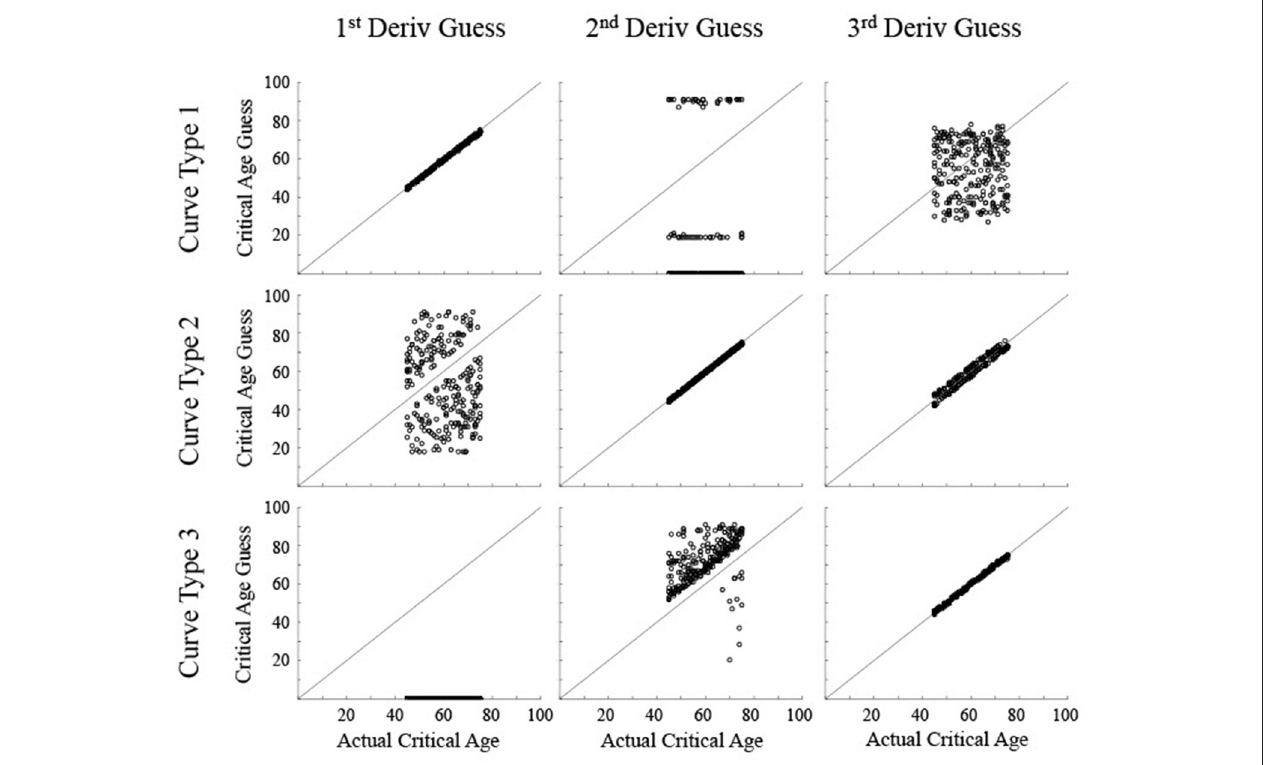
FIGURE 5 | Scatter plots show the critical age guesses for the Low Noise data ( σ the diagonal line indicate a match between the calculated critical age and the actual critical age of the stimulated data. Points along the x-axis indicate no derivative zero points for that